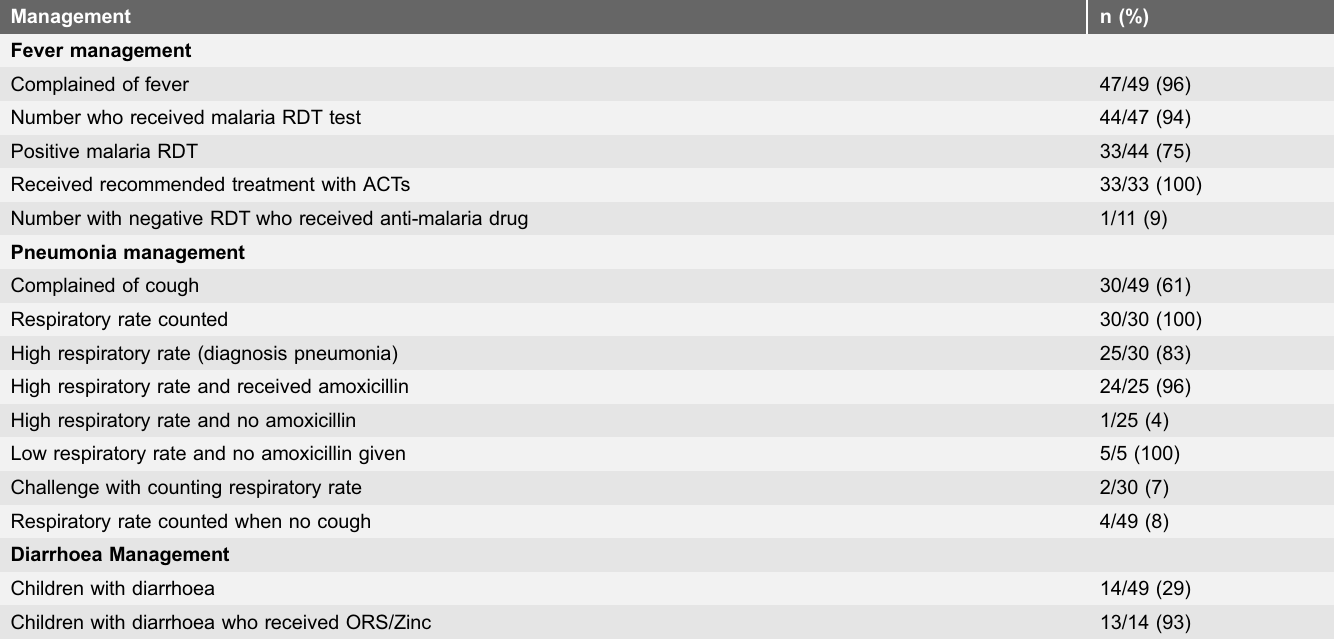
Table 4. Appropriateness of management of children at drug shops, from direct observation in the intervention area (N 5 49).